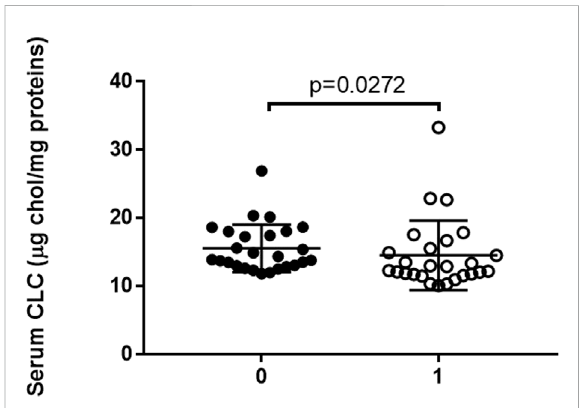
FIGURE 2 Serum cholesterol loading capacity (CLC) in FH subjects (N = 26) before and after 6 months of PCSK9-i treatment. Every dot of the graph represents the mean percentage of each triplicate analyses for serum sample. The horizontal line is the mean of each group. 0: FH subjects before PCSK9-i treatment; 1: FH subjects after 6 months of PCSK9-i treatment. 5 samples over 31 were not available for CLC